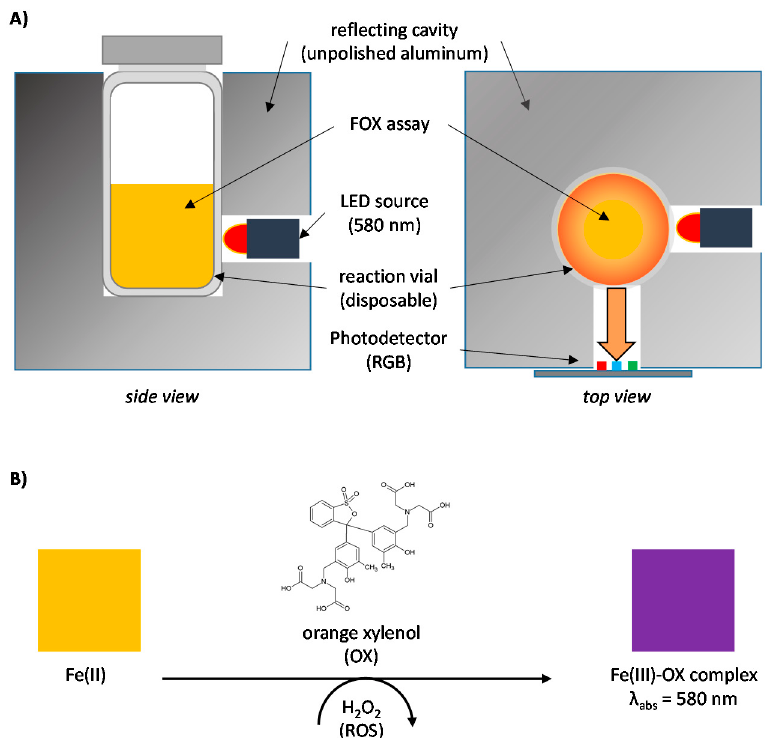
Figure 2. Principles of OPEA detection. ( A ) Schematic representation of the photonic detection strategy based on multiscattering-enhanced absorbance that enables highly sensitive absorbance change detection. ( B ) Description of the FOX assay in which the formation of a purple Fe(III)–OX complex reflects the overall redox balance versus Fe(III)/Fe(II).